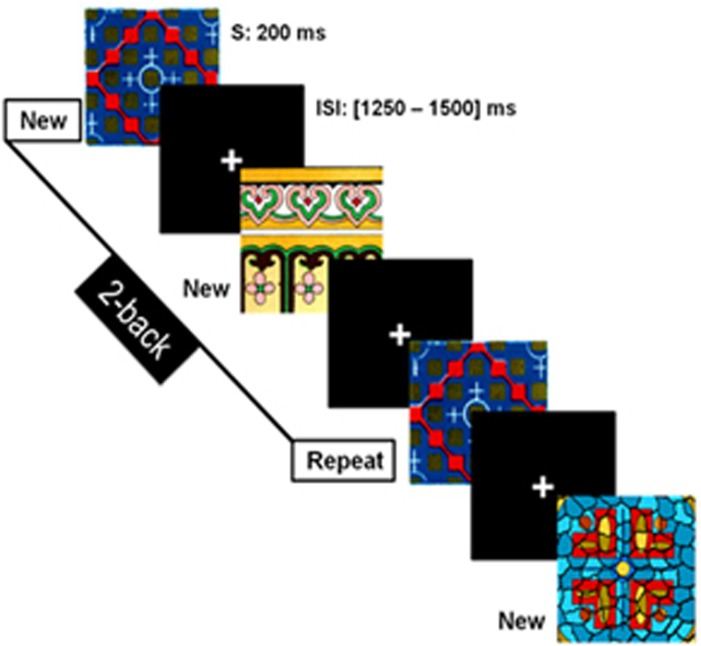
The n-back task. Schematic of the 2-back condition where the child is required to recognize that an image (Repeat) is the same as two images before (New; first occurrence of a picture). Each image (stimulus, S) appeared for 200 ms and was followed by a fixation cross displayed with an interstimulus interval (ISI) varying between 1250 and 1500 ms.